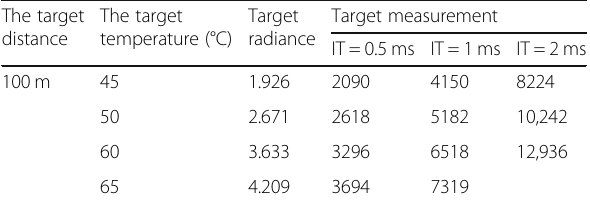
Table 3 Measurement results of gray bodies at different temperatures at a distance of 100 m The target